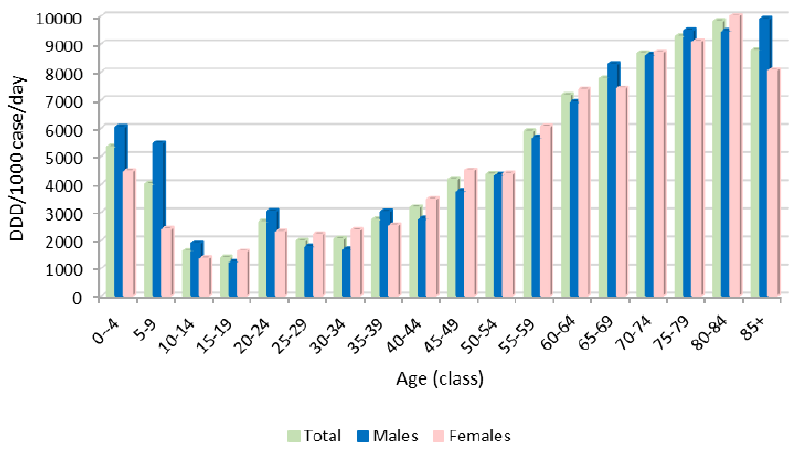
Figure 5. Pharmaceutical consumption (expressed as DDD/1000 cases/day) for all therapeutic categories by age and sex, in 2018.